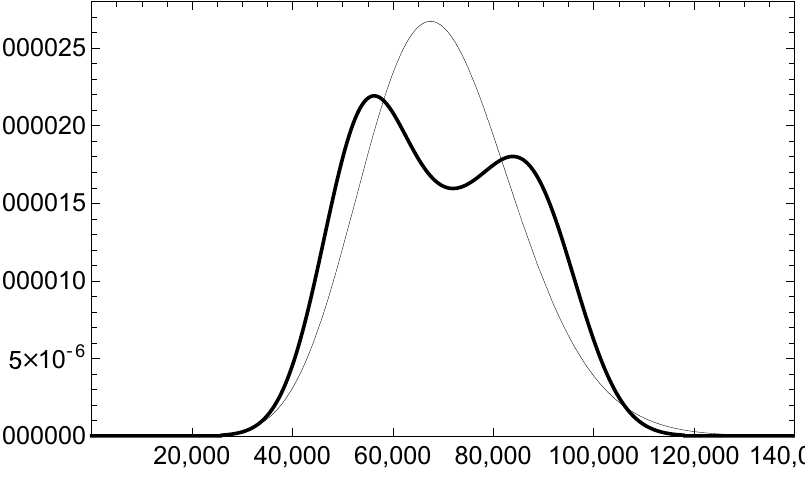
Figure 2. Empirical (thick) and fitted (thin) distribution of the total annual payments. Source: Devised by the